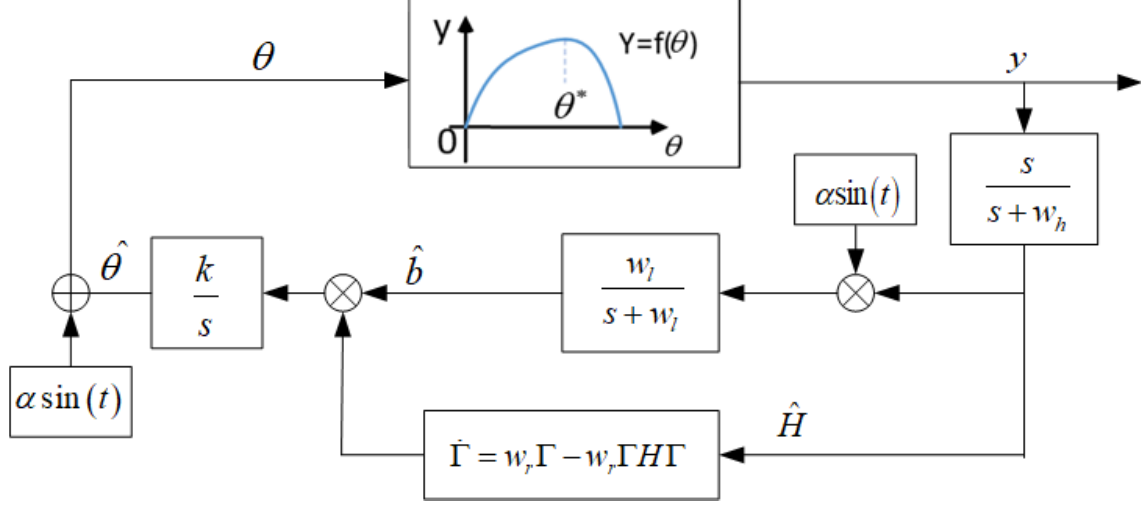
Figure 5. The Structure of the Newton-based extremum-seeking control for dynamic systems.